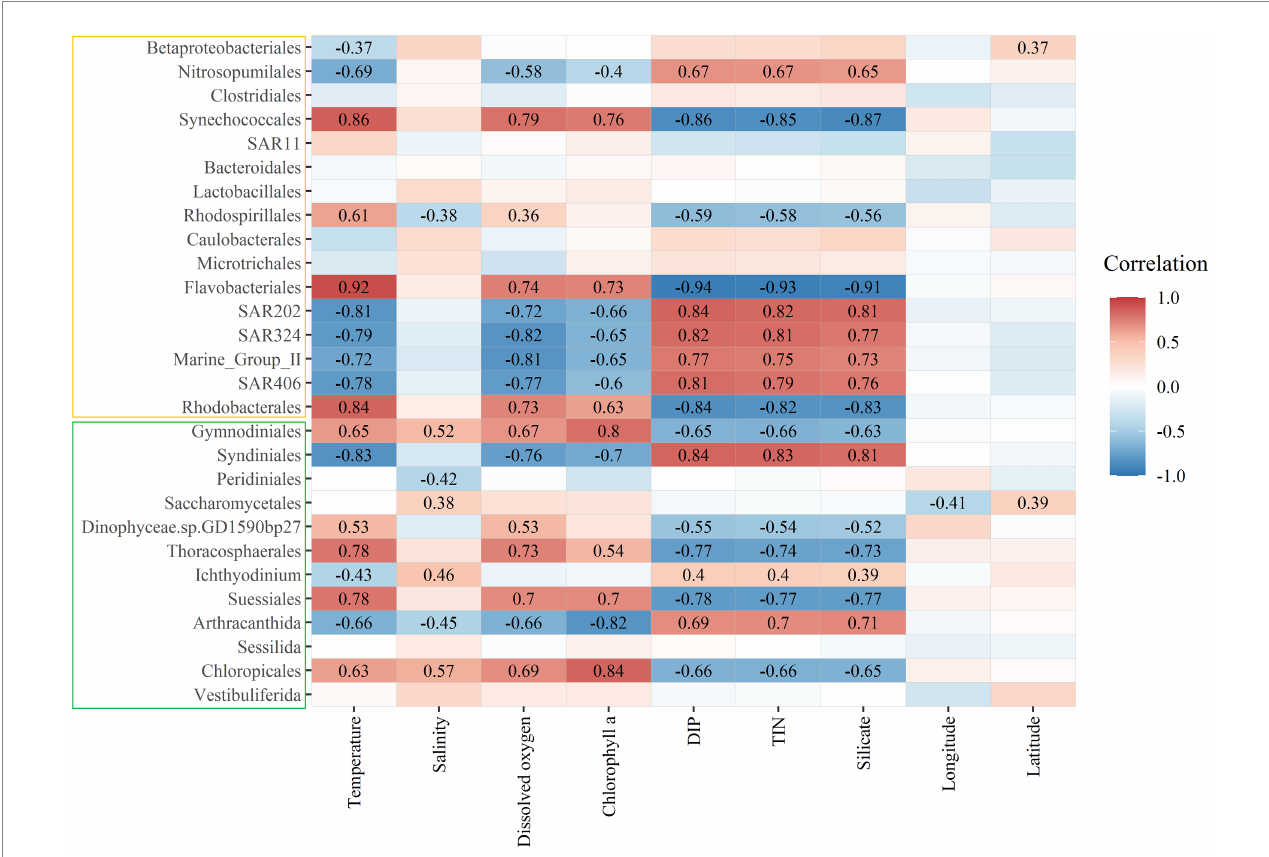
FIGURE 5 Heatmap depicting Spearman’s rank correlations between the relative abundances of main bacterial (yellow box) and microeukaryotic (green box) orders and environmental factors. Significant correlation coefficient values were marked in the figure. DIP, dissolved inorganic phosphate; TIN, total inorganic nitrogen.